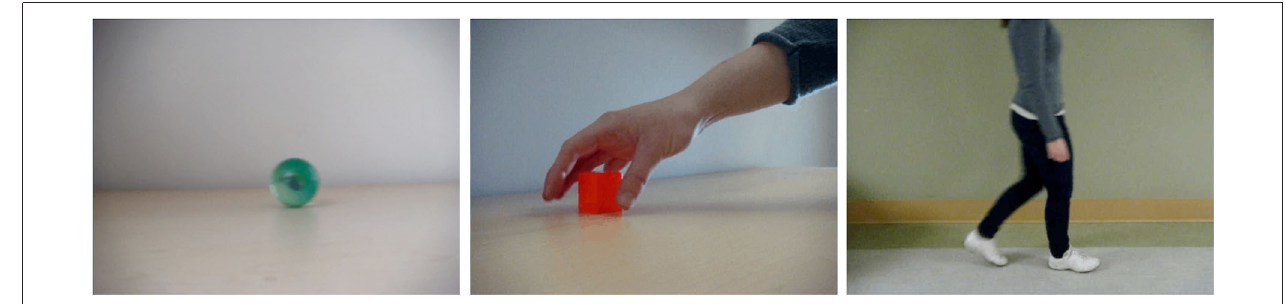
FIGURE 1 | Screenshot examples for the three different conditions (from left to right object movement, reaching for an object, walking)